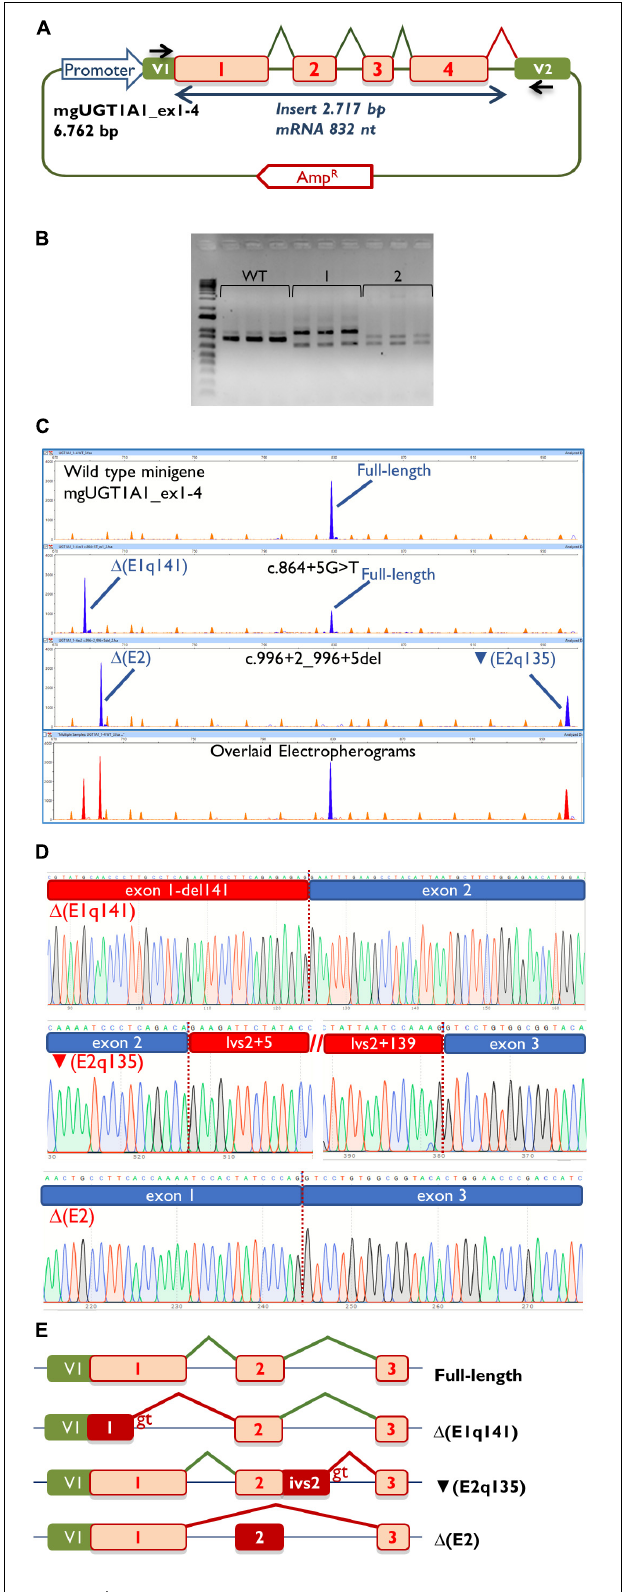
FIGURE 2 | Splicing functional assays of minigene mgUGT1A1_ex1-4. (A) Structure of the construct. Splicing reactions in eukaryotic cells are represented by broken lines; specific vector exon primers are shown as black arrows in V1 and V2. (B) Agarose gel electrophoresis of RT-PCR products (in triplicate) of the wild type and mutant minigenes: 1, c.996+2_996+5del; 2, c.864+5G > T. The 1-kb DNA plus ladder is shown on the left. (C) Fragment analysis of FAM-RT-PCR products of the wild type and mutant minigenes experiments. Transcripts are shown as blue peaks while the LIZ1200 size standard is shown as orange peaks. Below is shown an electropherogram where the wild type and mutant ones have been overlaid. In this case aberrant transcripts are shown as red peaks. (D) Sequences of aberrant transcripts. (E) Diagrams of splicing events in the full-length and anomalous transcripts.